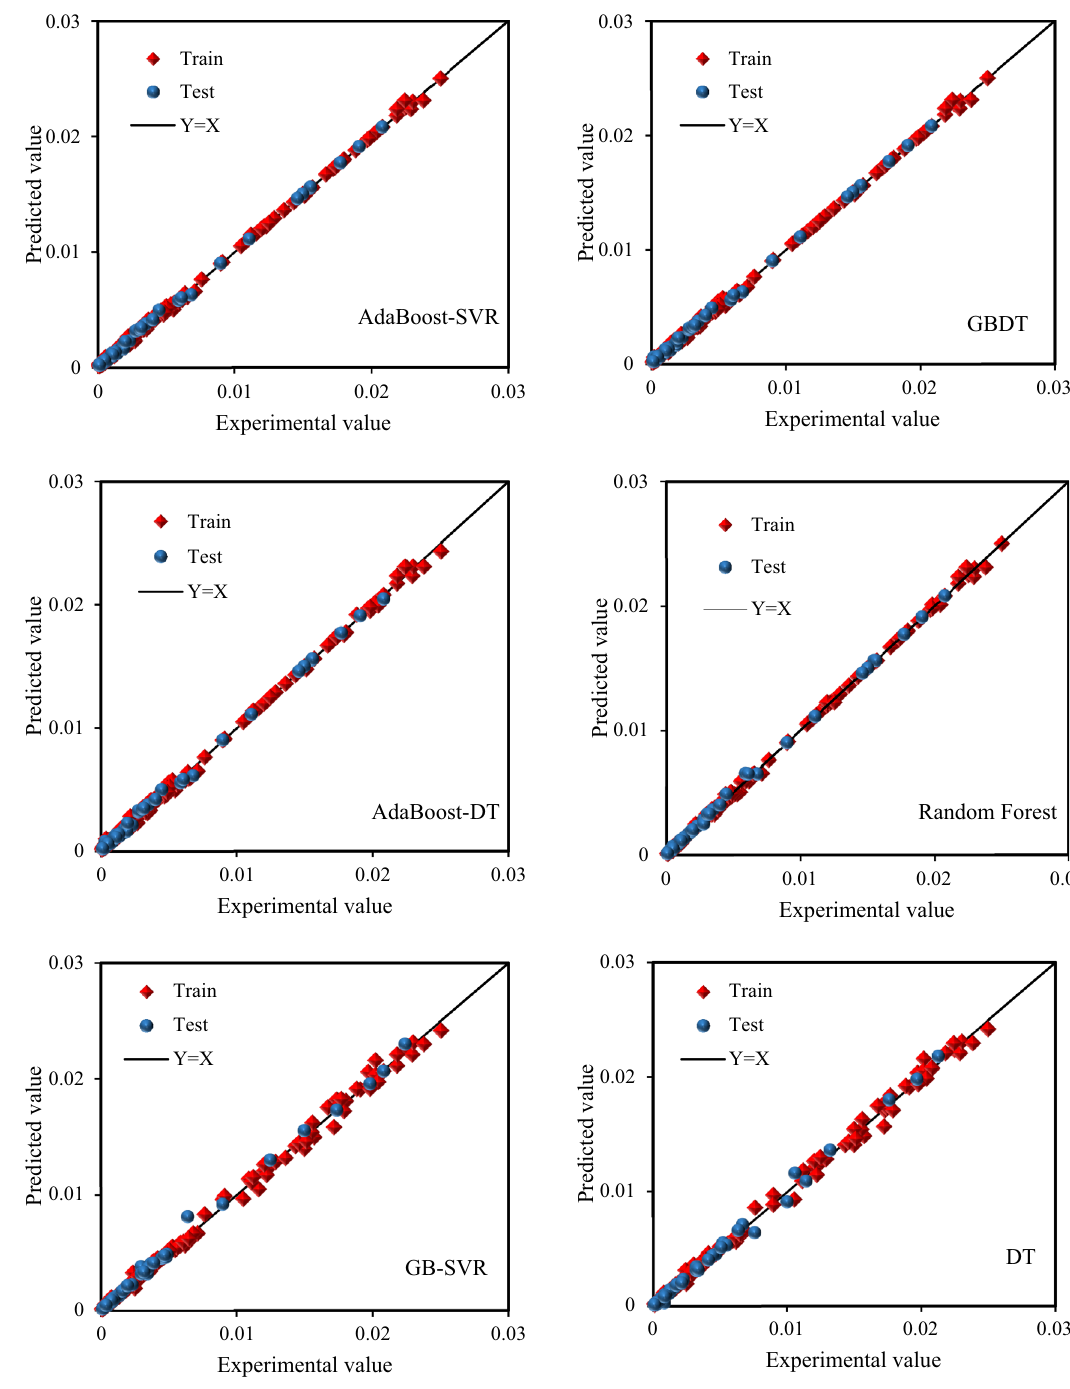
Figure 4. Cross plots of the developed models in this